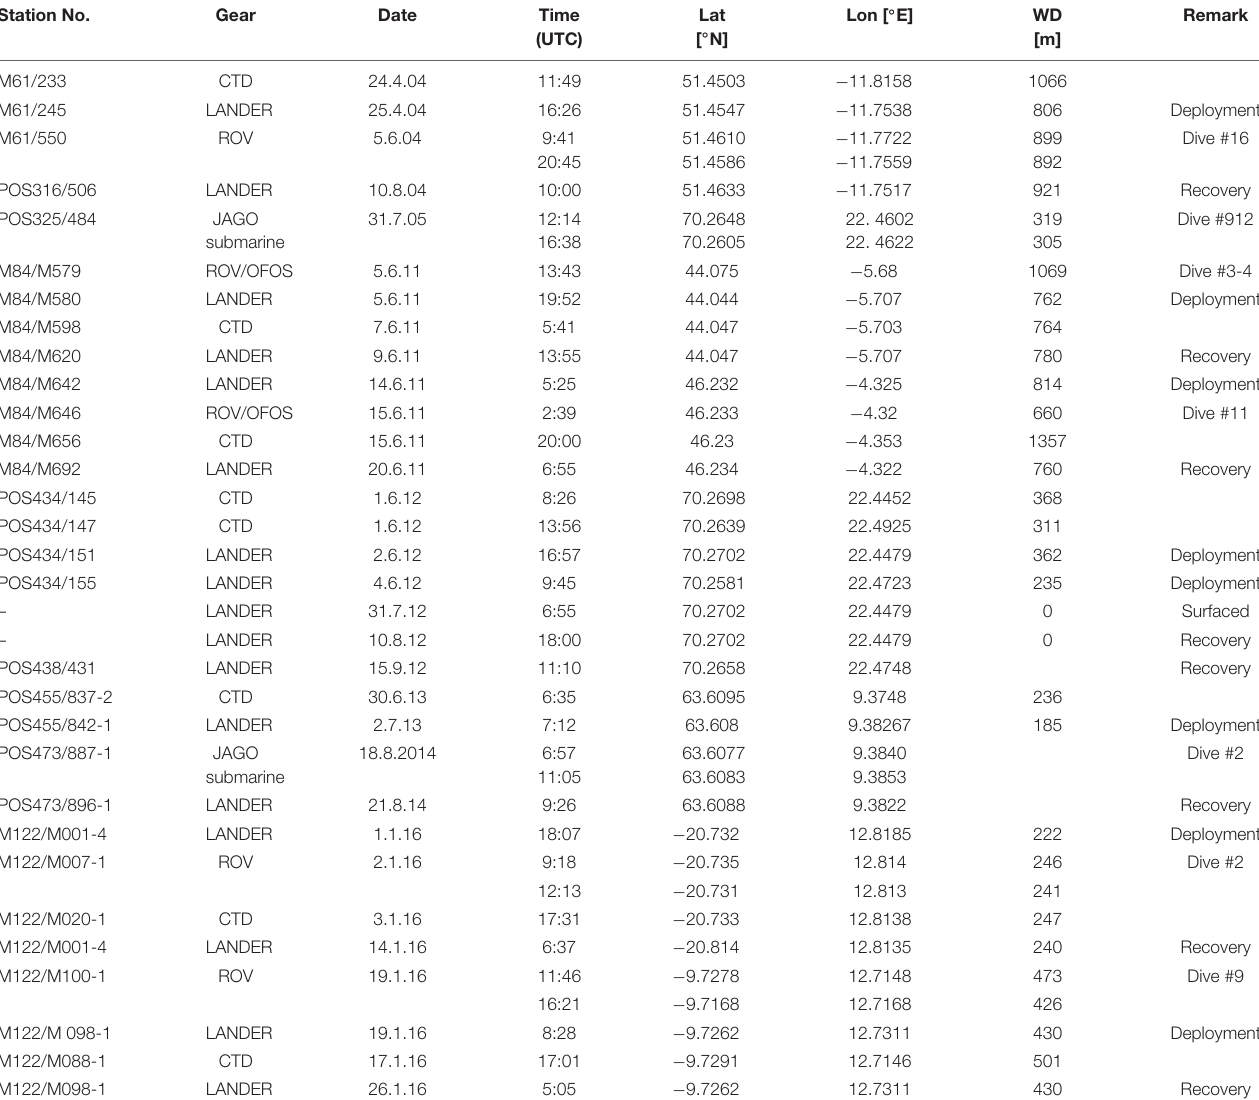
TABLE 2 | Metadata for CTD casts, ROV and submarine dives and lander deployments. Station